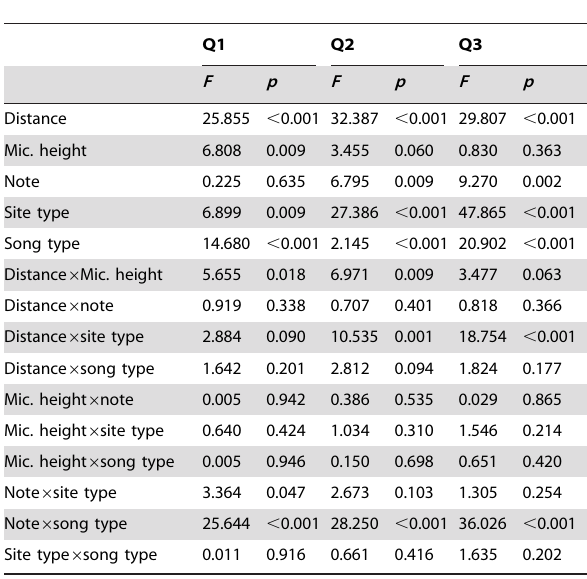
Table 3. Factorial ANOVA table of experiment 1 showing the main effects and two-way interactions of all the variables three quartiles of tail energy decline.